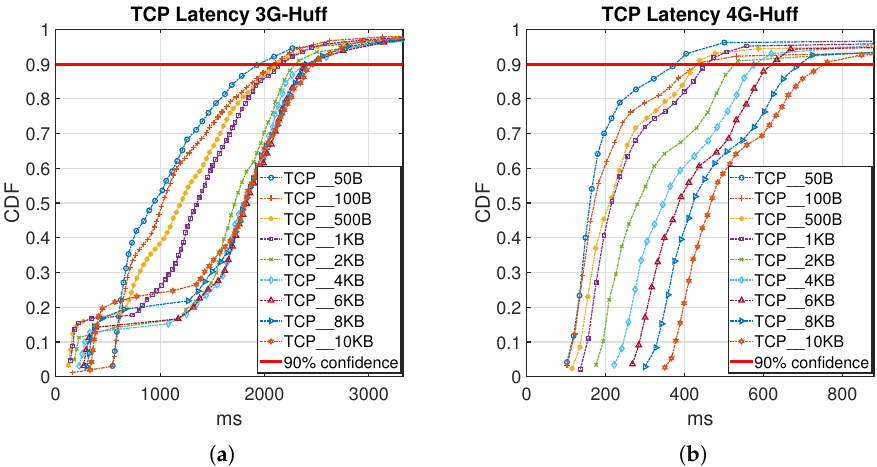
Figure 9. CDF plot for different data packet size both for 3G ( a ) and 4G ( b ) using Huffman Compression.